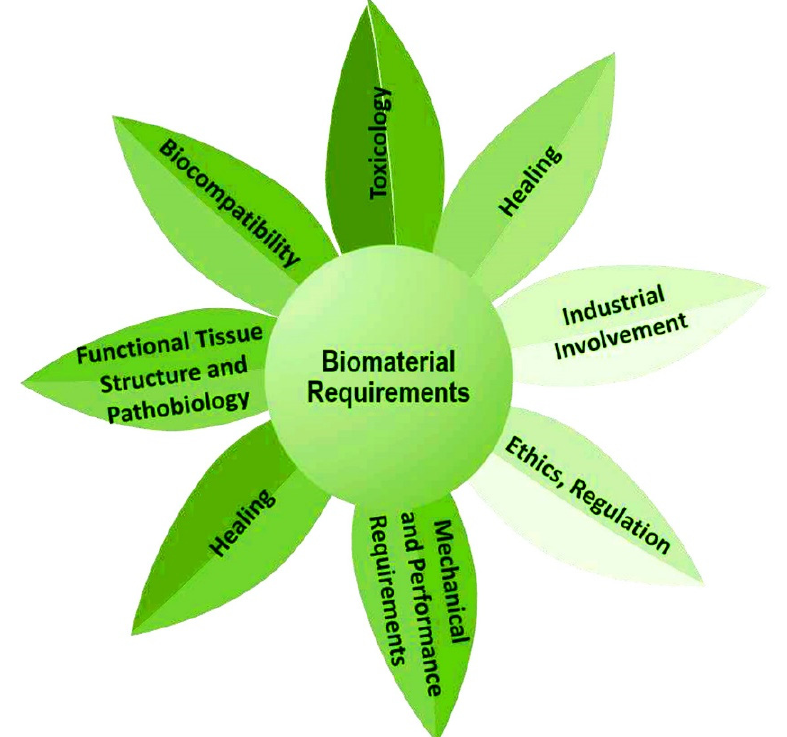
Figure 8. The essential requirements involved in biomaterial design for nutraceuticals delivery.